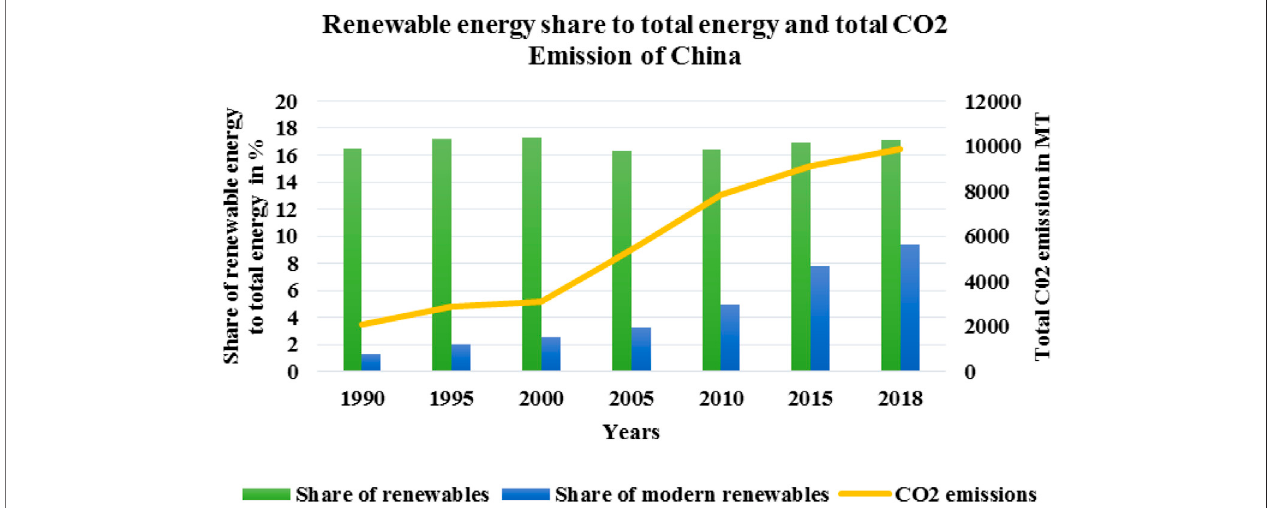
FIGURE 1 | Renewable energy share to total energy and total CO 2 emission of China. Source: IEA Sustainable Development Goal 7 https://www.iea.org/reports/ tracking-sdg7-the-energy-progress-report-2021.